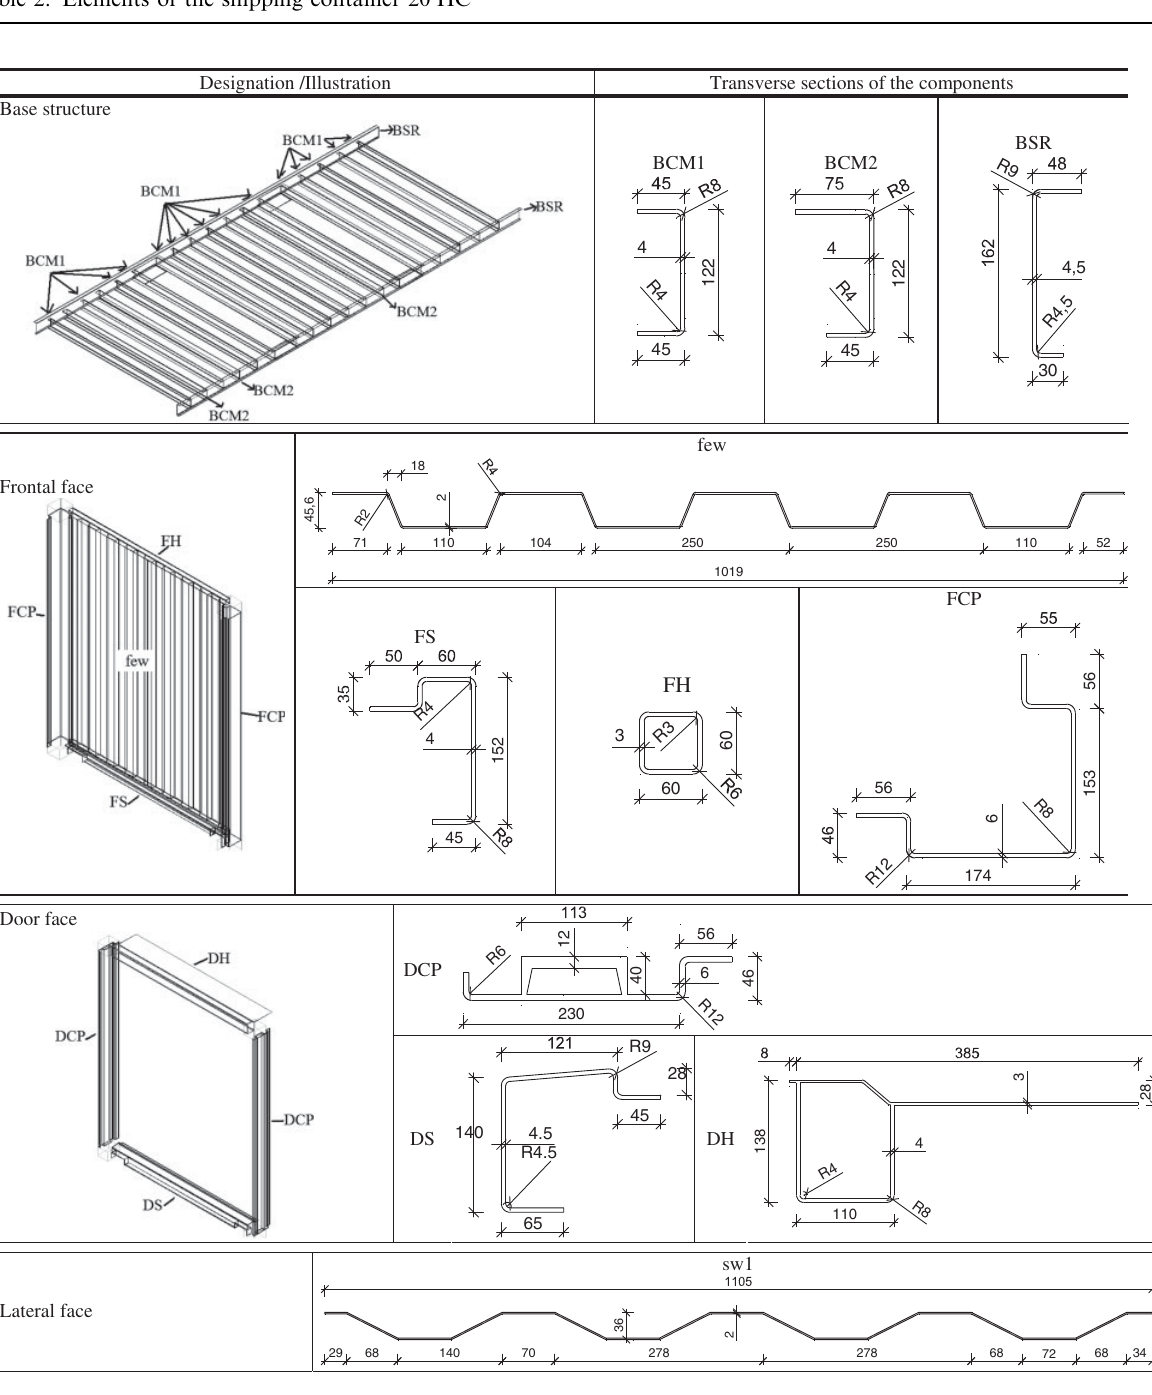
Table 2. Elements of the shipping container 20’HC